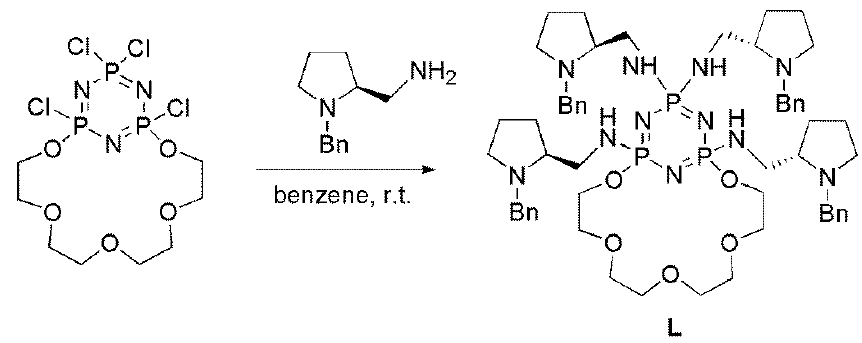
Table 1. The stability constants of the complexes of the investigated ligand with Ag + ions determined by potentiometric measurements.